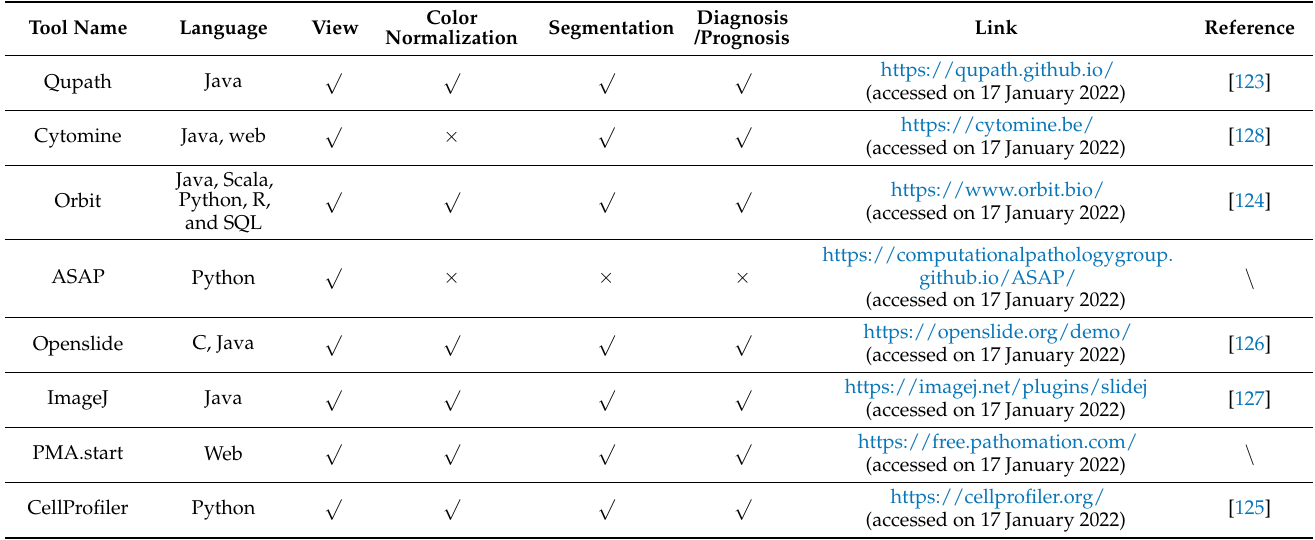
Table 3. Summary of publicly available tools in computational